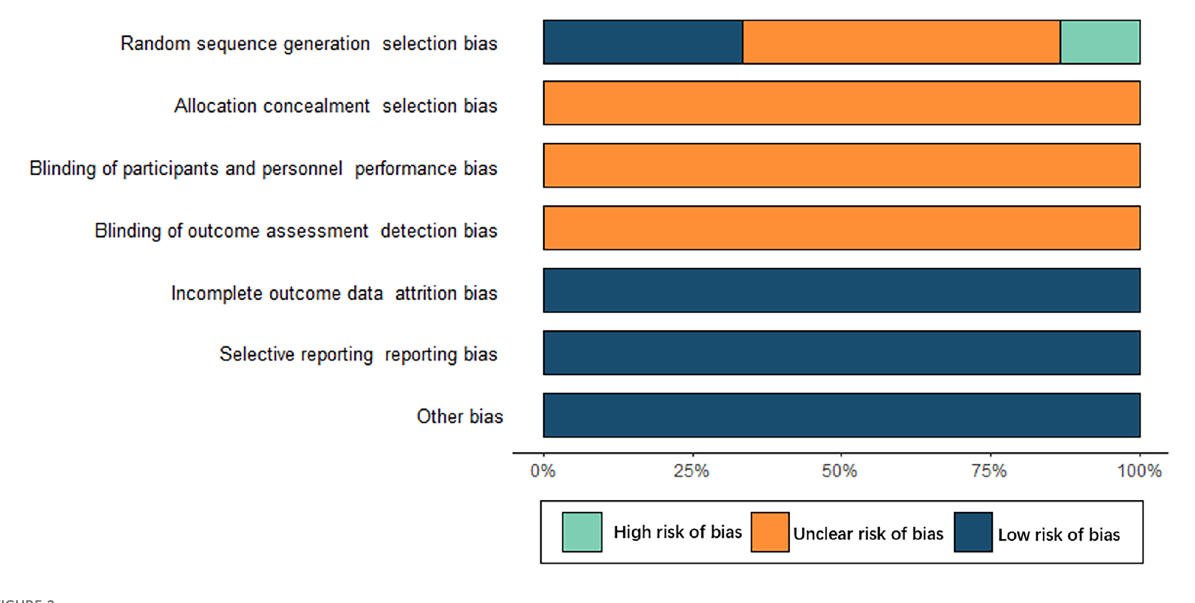
FIGURE 2 Results of risk of bias